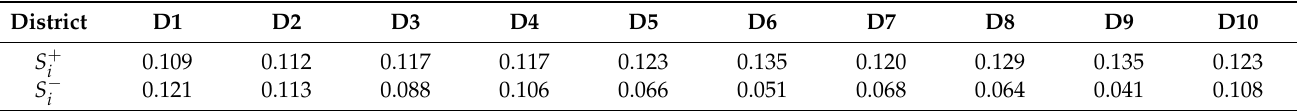
Table 5. The distances between the 10 districts and the positive and negative ideal solutions.